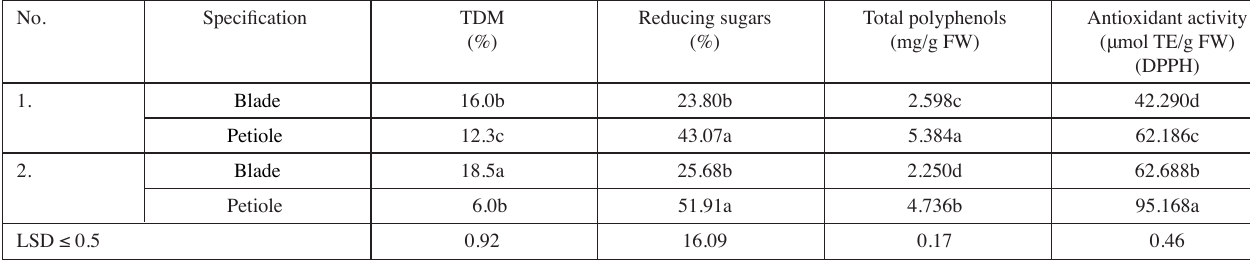
Tab. 3: Biochemical composition of sweet potato leaves.